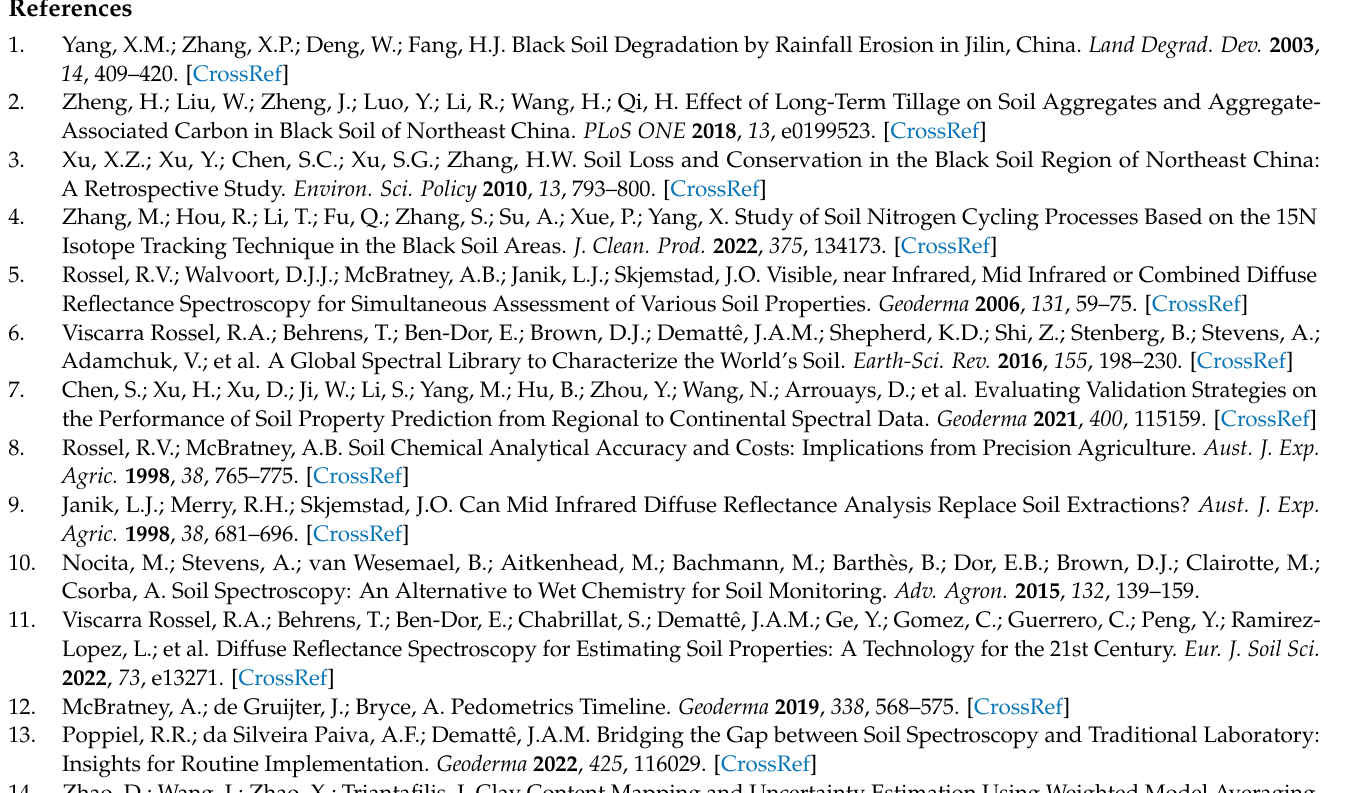
Figure A2. Sca tt er plot of predicted soil TN and TP based on laboratory MIR. Figure A2. Scatter plot of predicted soil TN and TP based on laboratory